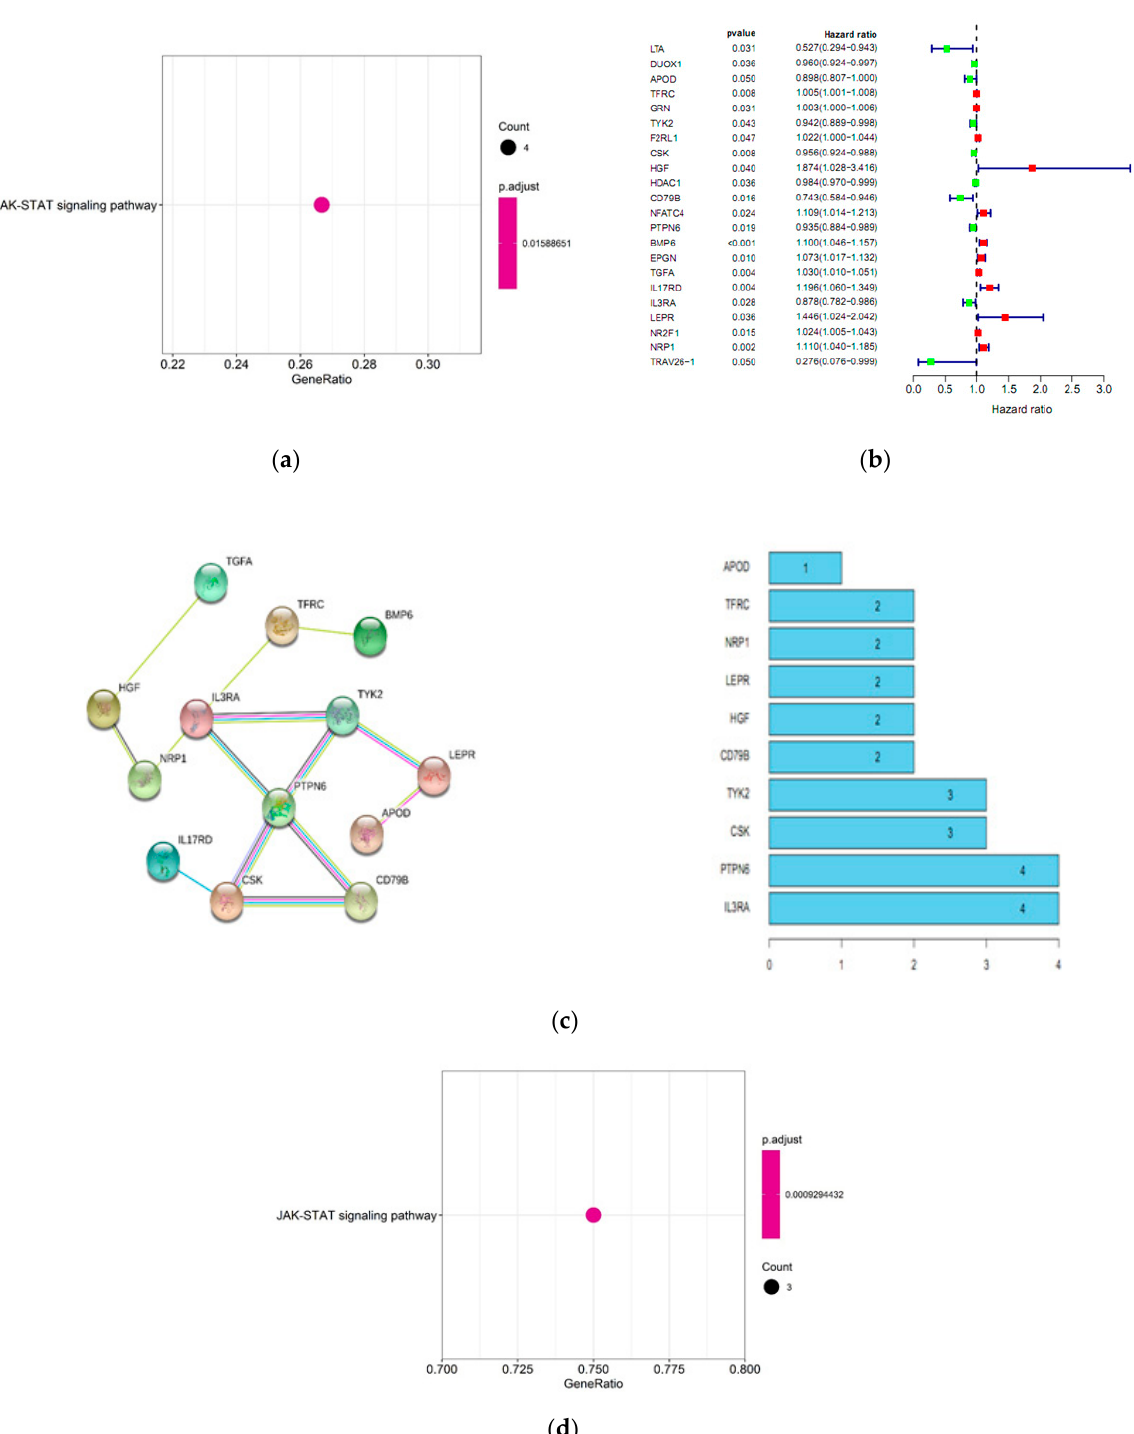
Figure 2. Identification of SIRGs. ( a ) The most significant KEGG pathways for SIRGs. ( b ) A forest plot of hazard ratios. The left is the list of SIRGs and their prognostic values showing as name, p ‐ value, and the hazard ratio (95% CI), and the right is the relevant forest plot; Green bar, protective factor; red bar, adverse factor. ( c ) PPI network. The left is the PPI network, and the right is the number of interactive genes for each gene. ( d ) The most significant KEGG pathways for the hub SIRGs. SIRGs, immune ‐ related genes associated with survival.